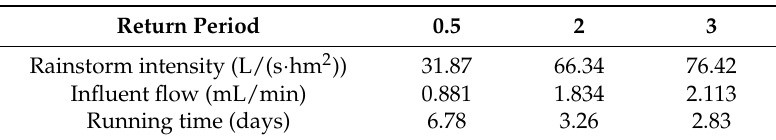
Table 2. Calculation of water